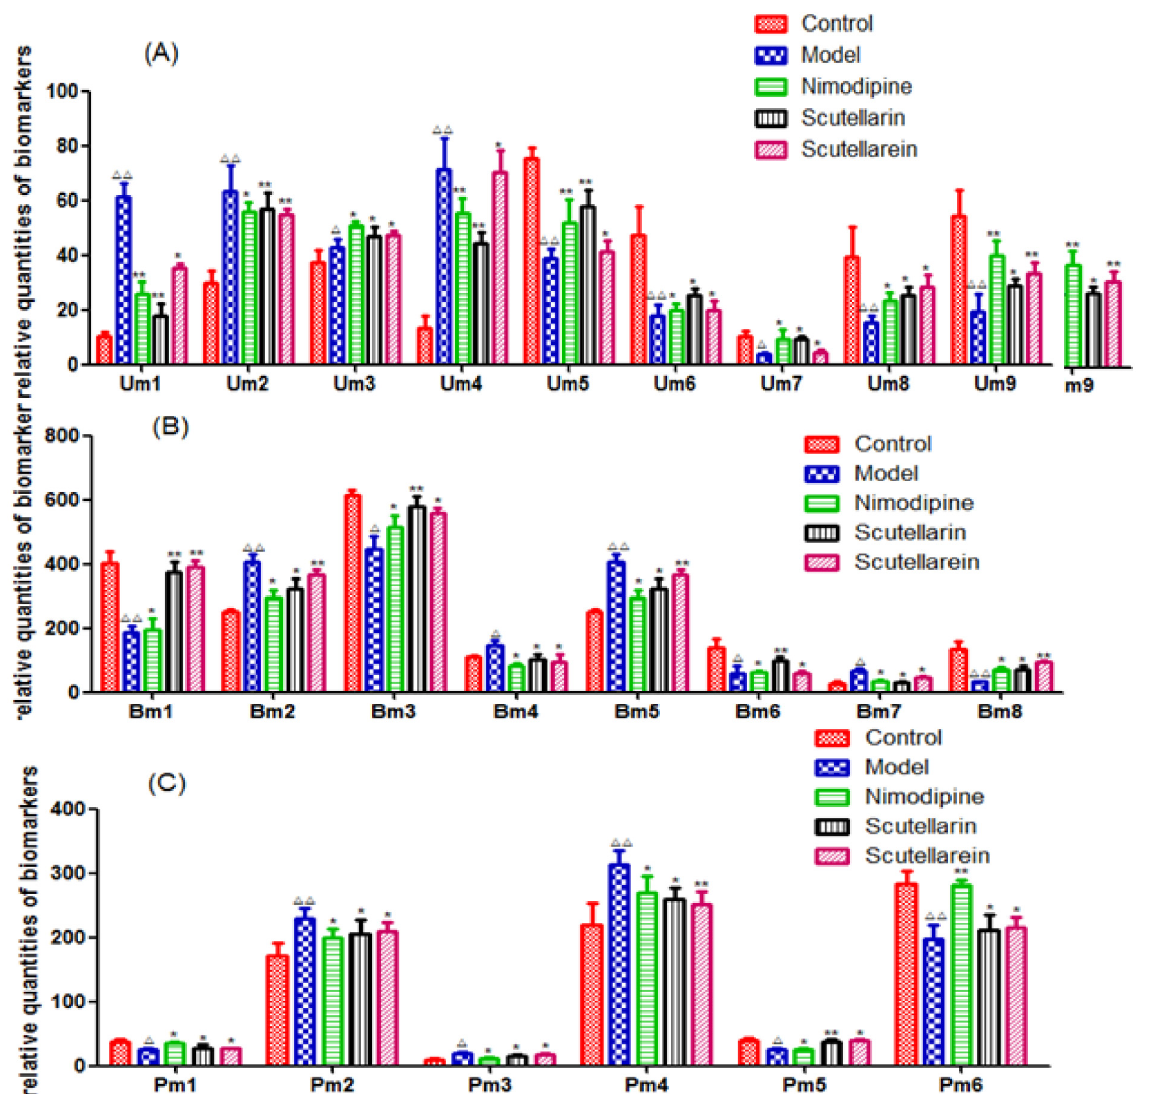
Fig 4. Changes in the relative quantities of target metabolites identified in different groups. Um, urine metabolites; Bm, brain metabolites; and Pm, plasma metabolites. Statistical analysis compared with the sham-operated group, 4 p < 0.05, 44 p < 0.01, and compared with the model group, * p < 0.05, ** p < 0.01; (A) 9 endogenous metabolites in the urine; (B) 8 endogenous metabolites in the brain tissue; and (C) 6 endogenous metabolites in the